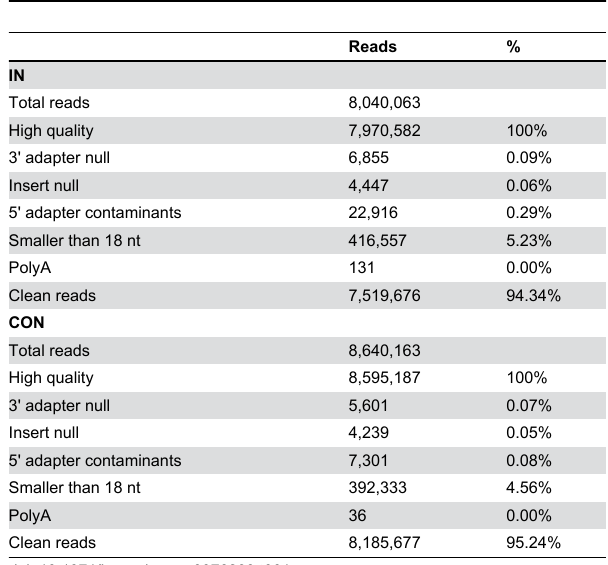
Table 1. Statistical summary of sRNAs from T. reesei IN and CON samples.